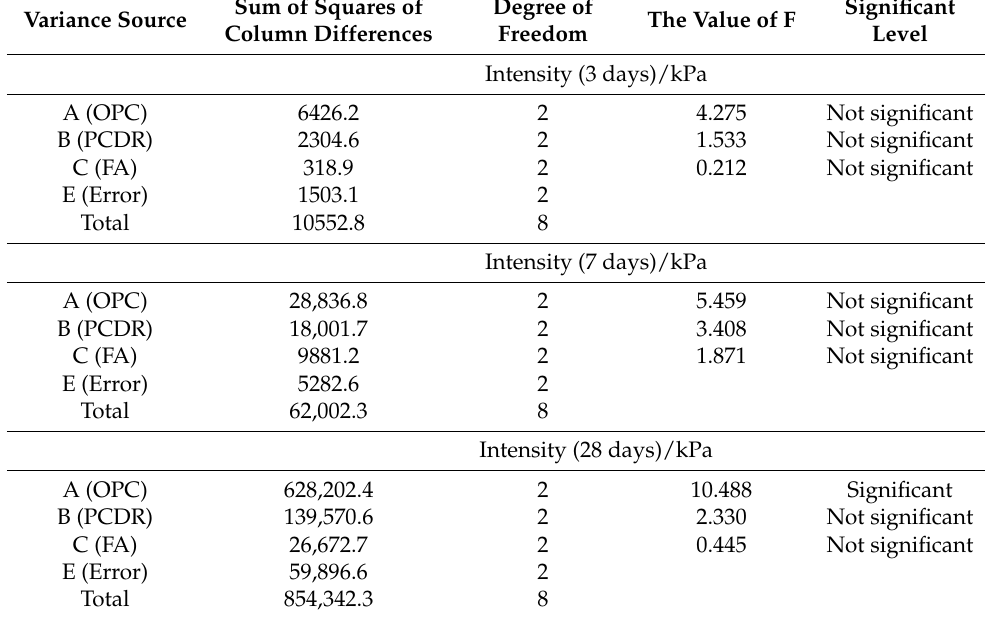
Table 8. Analysis of variance of orthogonal test results when the initial water content of mud is 50%.